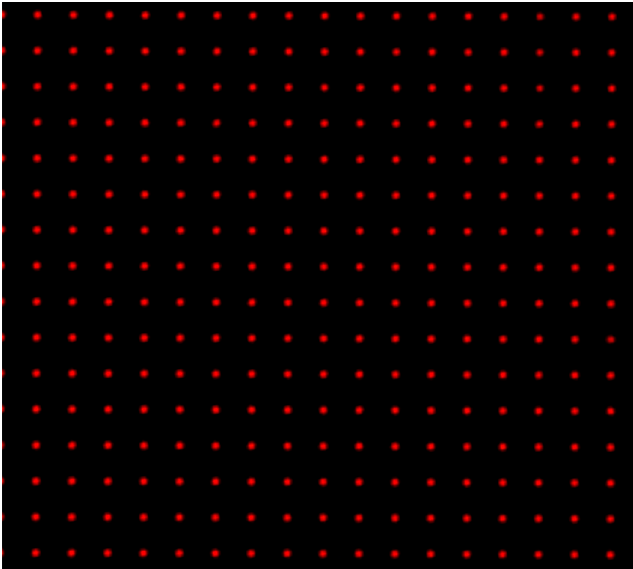
Figure 16. Back focal plane of the microlenses. When imaging the back focal plane, a grid of dots will appear in the camera chip. Each dot should be located at the center of each microlens. Use the 6-axis kinematic mount to ensure that the yaw and pitch angles of the microlens array are correct (if they are not, some microlenses will be in focus, while others are not). Ensure that the microlens grid is as aligned with the pixel grid as possible. (Magnified view).